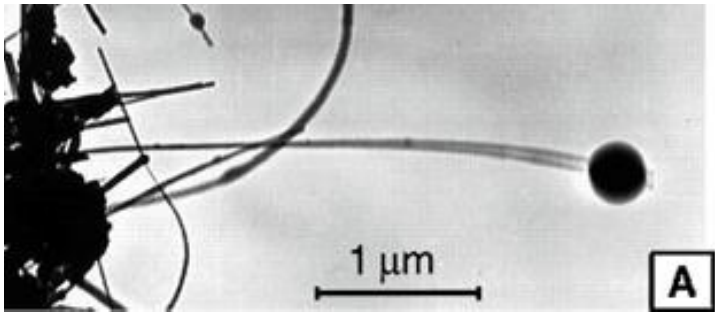
Figure 2. Resonance vibrations of a nanotube loaded with a carbon nanoparticle. Adapted with permission from [26], Copyright AAAS, 1999.